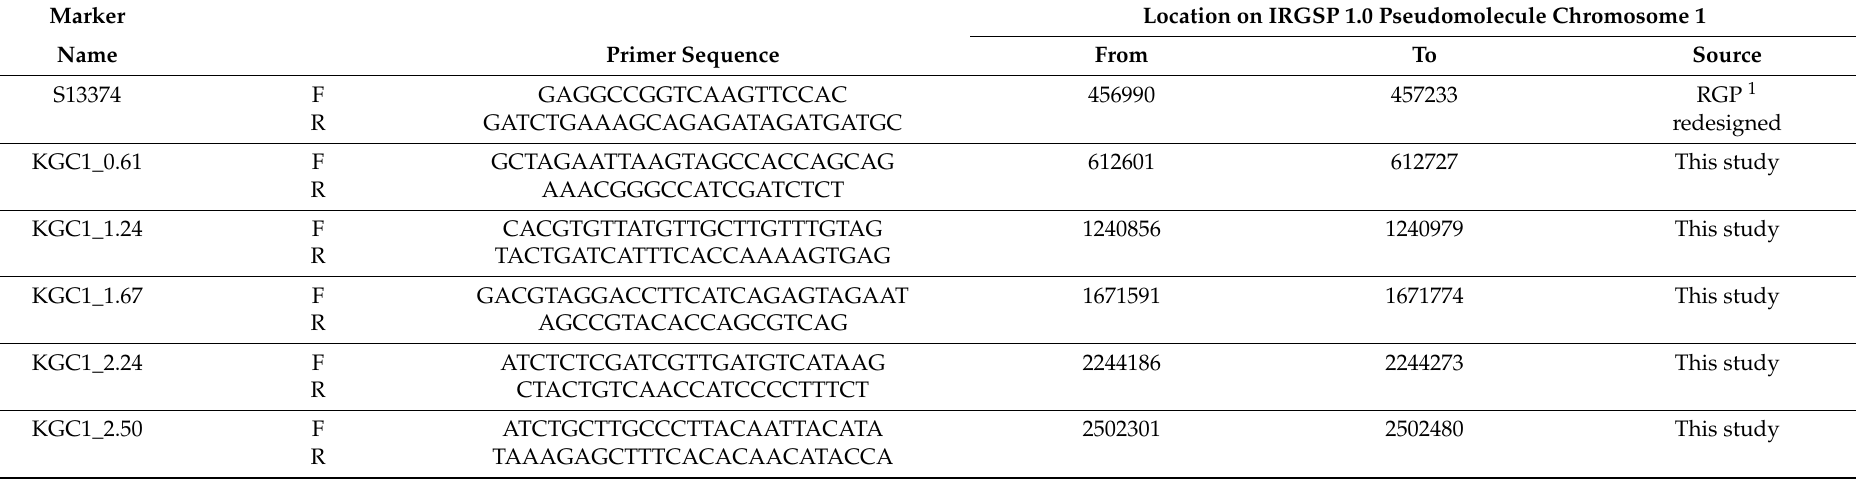
Table 2. Primer sequences of Indel markers designed or redesigned for mapping the S57